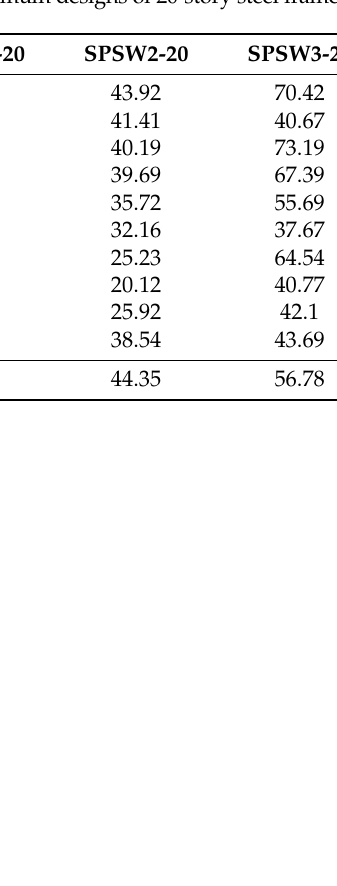
Table 12. Percentage of story shear resisted by steel plate in optimum designs of 20-story steel frame (%).